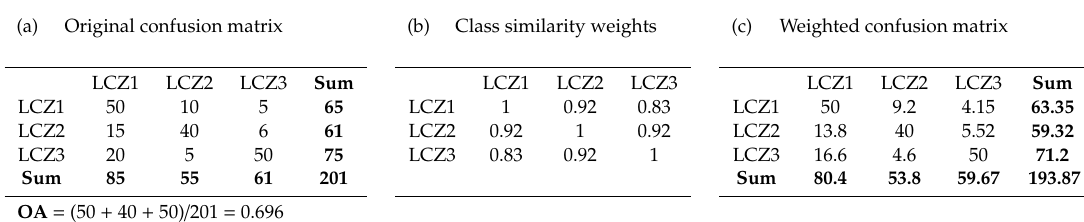
Table 1. Method used to calculate weighted accuracy (WA). Values in (a) are multiplied by weights in (b) to generate a weighted confusion matrix (c). WA is calculated from the values in (c). Local climate zone (LCZ); overall accuracy